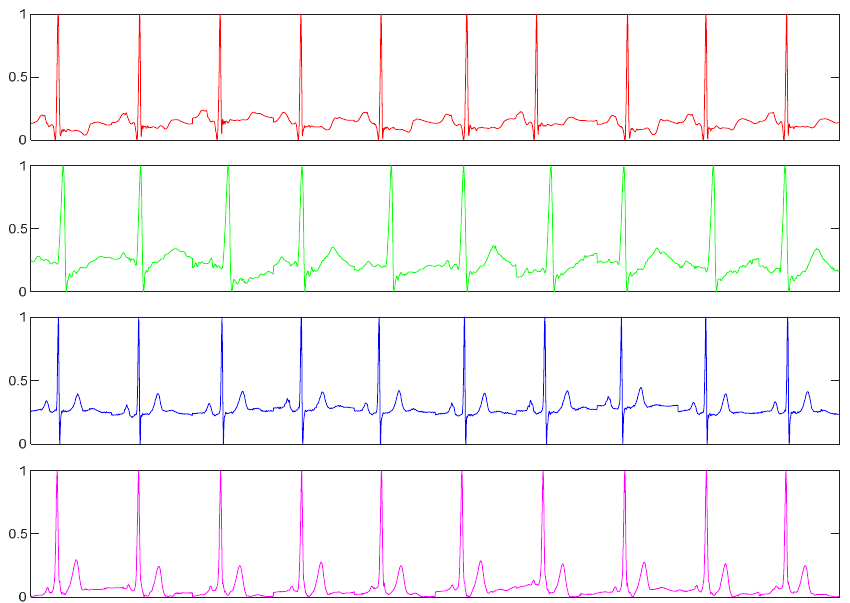
Figure 10. ECG sample of 10 heart beats from four different subjects.